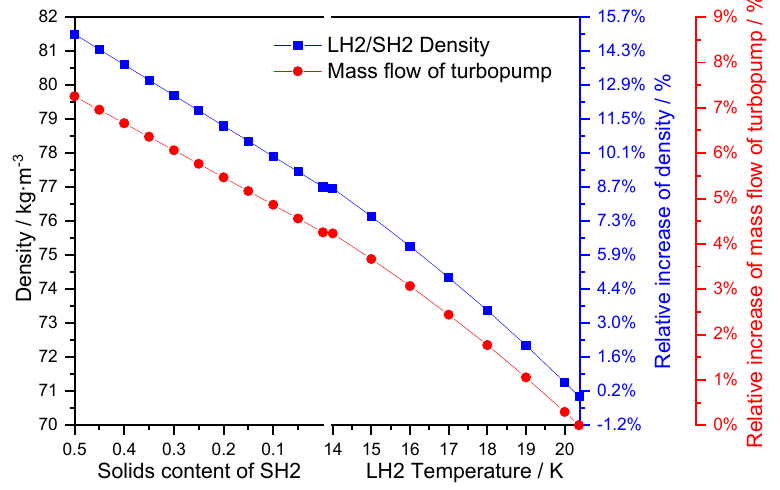
Figure 5. Effect of subcooling density of LH2/SH2 on the mass flow of the turbopump.